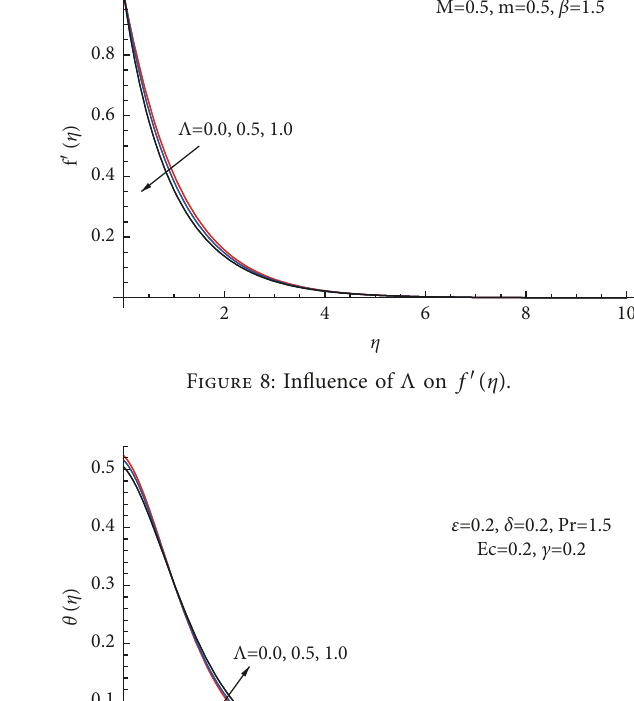
Figure 5: Influence of β on f ′ ( η ) .